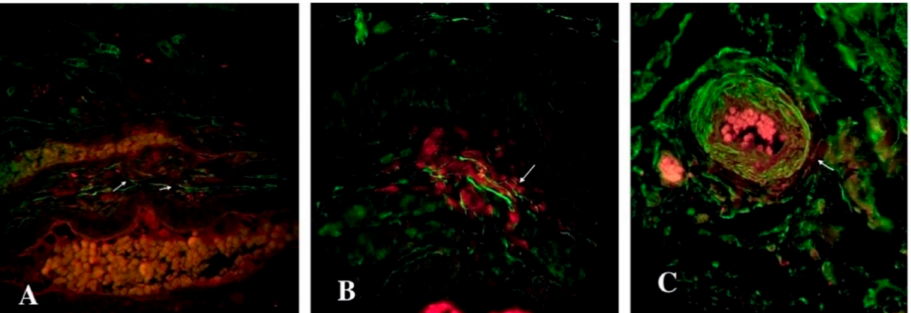
Figure 6. Double immunolabeling of the human oviduct tissue for CD34 (green, Alexa Fluor 488) and PGP 9.5 (red, Alexa Fluor 594)—( A ); for CD34 and iNOS (red, Alexa Fluor 594)—( B ); for CD34 and ChAT (red, Alexa Fluor 594)—( C ). Nerves are presented as red filaments accompanied by green structures (telocytes and blood vessels) longitudinally. Total magnification: ×